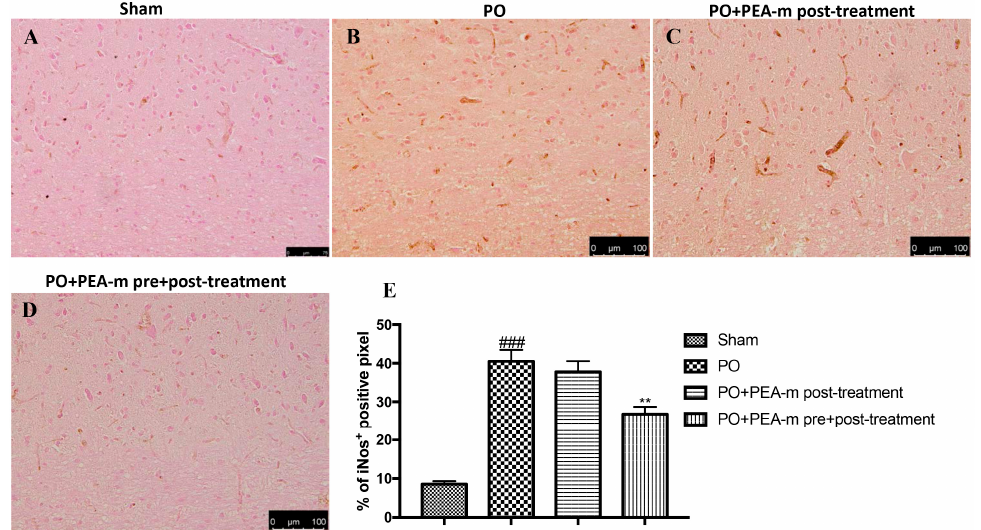
Figure 8. Effects of PEA-m on levels of inducible nitric oxide synthase. Immunohistochemical analysis showed no staining for iNOS in the sham group ( A ). Increased iNOS expression was observed in the lumbar spinal cord collected 24 h after PO ( B ). A non-significant reduction was observed in the PO + PEA-m post-treatment group ( C ), while low levels of iNOS were found in rats treated with PEA-m both before and after plantar incision ( D ). The data are also presented graphically as a percentage of pixel cells ( E ). ### p < 0.001 vs. sham; ** p < 0.01 vs. PO.